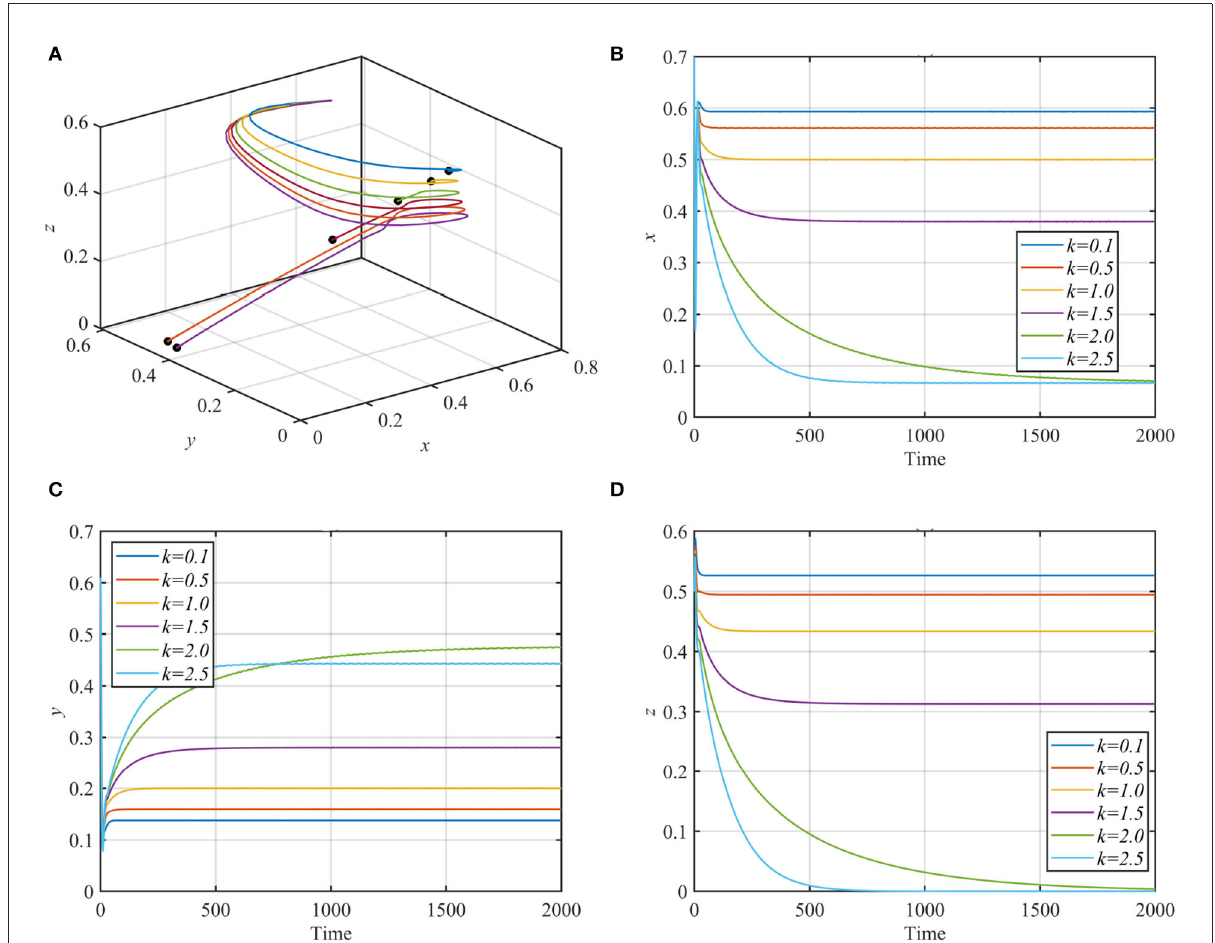
FIGURE3 Trajectories of system (1) using data given in equation (17) with different values of k . (A) 3D-Phase portrait of system (1) for different values of k . (B) Time series for the trajectory of x , in which x decreases but remains positive as k increases. (C) Time series for the trajectory of y , in which y increases as k increases. (D) Time series for the trajectory of z , in which z decreases as k increases and approaches zero for k >